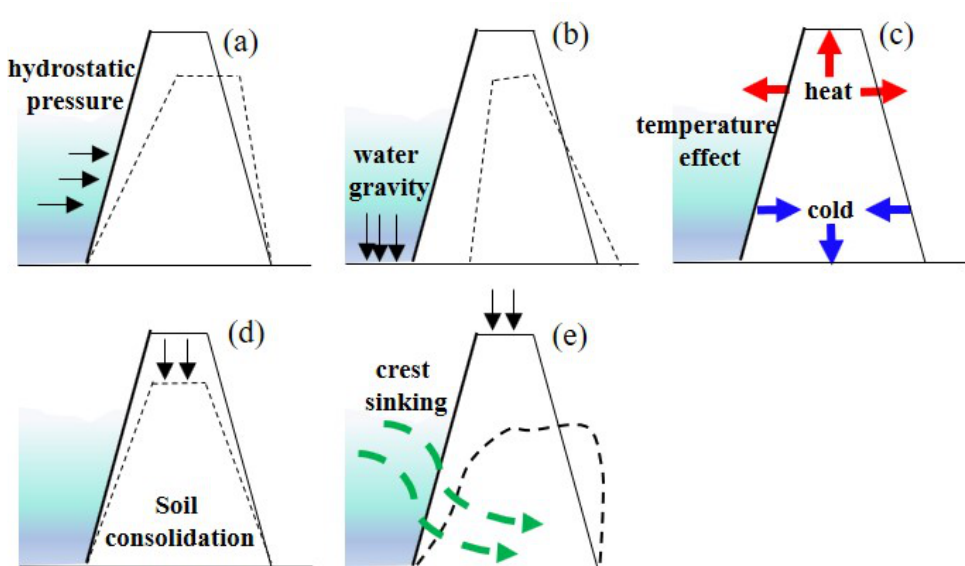
Figure 8. The schematic sketch for the deformation on the Dam. ( a ) hydrostatic pressure; ( b ) wa- ter gravity; ( c ) temperature effect; ( d ) soil consolidation; ( e ) continuous crest sinking and lateral extrusion [31].